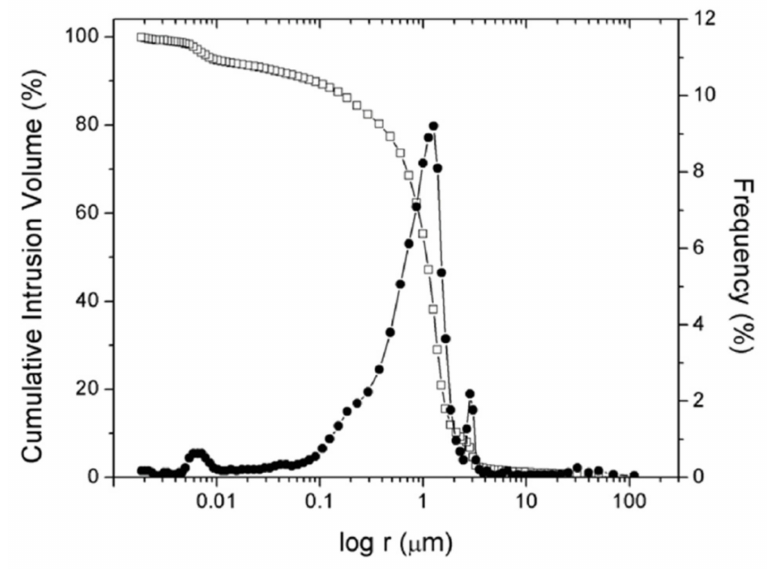
Figure 5. Cumulative intrusion volume and pore size distribution curves of studied